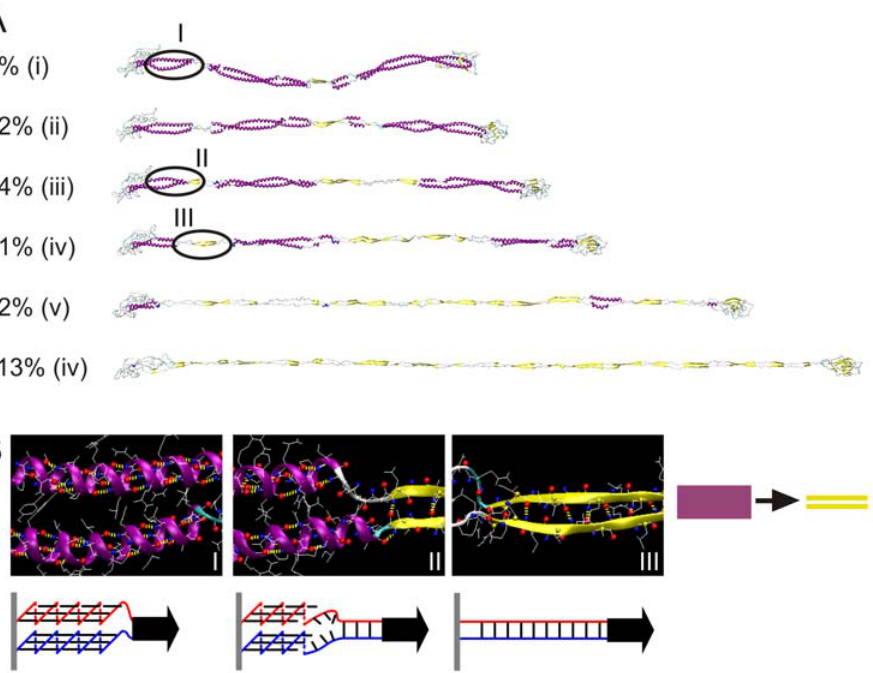
Figure 6. Simulation snapshots and structural analysis during pulling of a dimer. Panel A displays snapshots as the applied tensile strain is increased up to 113%. Panel B depicts snapshots of the right part of the 1A segment as the a - b transition occurs (frames I to III correspond to those highlighted in panel A). The schematics in the lower part describe the atomistic details of the a - b transition mechanism.